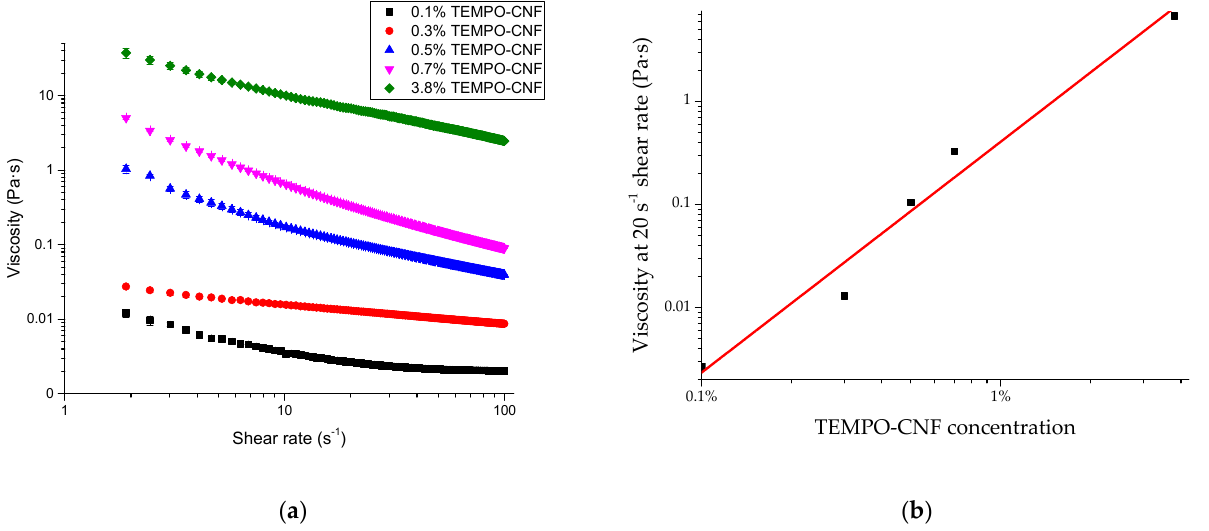
Figure 2. Viscosity of corn-stover derived TEMPO-CNF. ( a ) Viscosity as a function of shear rates; ( b ) viscosity as a function of TEMPO-CNF concentration at selected shear rate (20 s − 1 ).